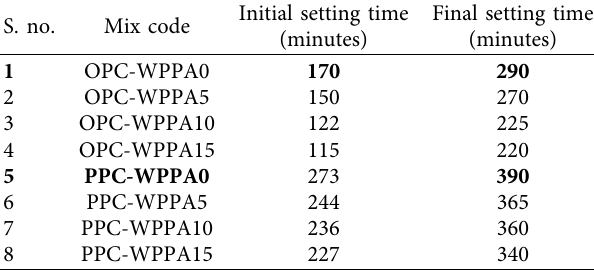
Bold shows demarcation with controlling mix. Table 9: Setting time of blended pastes of OPC-WPPA and PPC-WPPA.